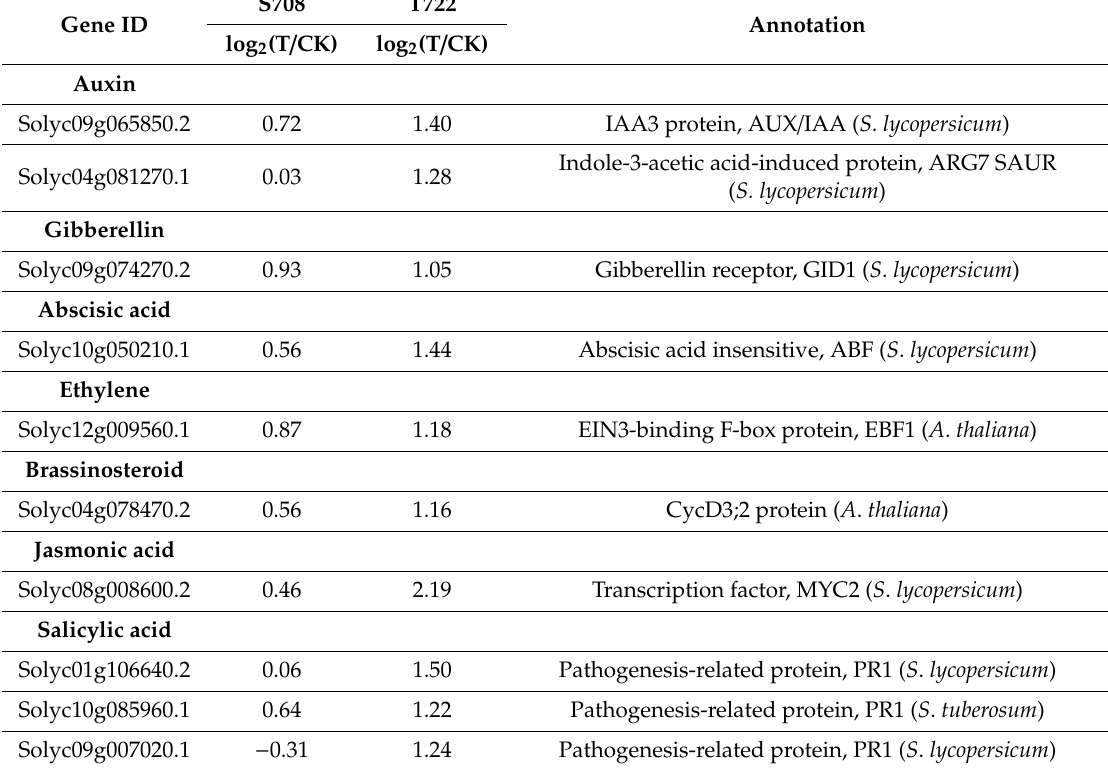
Table 4. List of selected genes induced by sub-optimal temperature (T, 15 / 10 ◦ C) in the significantly enriched KEGG pathway “plant hormone signal transduction” only in T722. S708 and T722 tomato cultivars grown under normal (CK, 25 / 18 ◦ C) and sub-optimal temperature conditions. Values are the log 2 ratio (T / CK) for genes more than 1 or less than − 1 with FDR < 0.05 as the threshold to judge the significance of gene expression di ff erence between the two